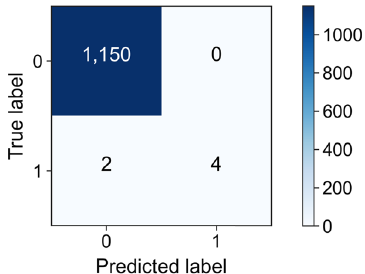
Fig. 8 The network of Zachary karate Club with injected edges (Experiment 1). Precision and F1 score 0.8. Here π = 0.25, µ 0 = =